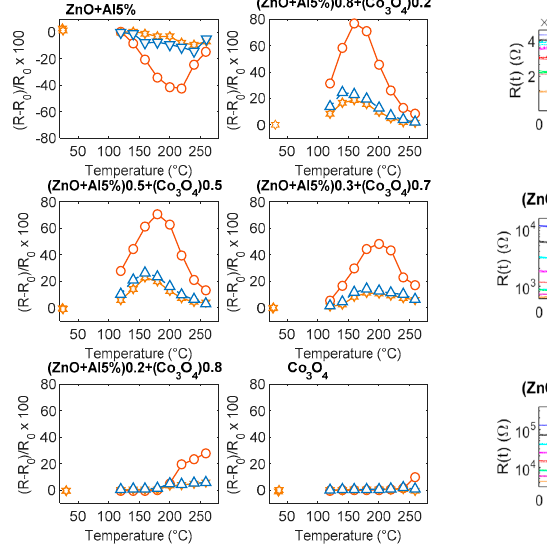
Figure 12. (a) Response to CO as a function of temperature. Marker triangles—humid environment, air and 25 ppm CO (RH = 50%). Marker stars—dry environment, air and 25 ppm CO. Marker circles—dry environment and 1000 ppm CO. (b) Responses to variable CO concentrations as functions of time for the different materials. The eight graphs in each subplot are the sensor responses recorded at different and constant temperatures in the range (120 °C–260 °C) with 20 °C steps, as per legend. The measurements are performed changing the test mixture composition in the following way: 4 min dry air, 4 min dry air and CO (2000 ppm), 8 min dry air, 4 min dry air and CO (1000 ppm), 8 min dry air, 4 min dry air and CO (500 ppm), 4 min dry air.